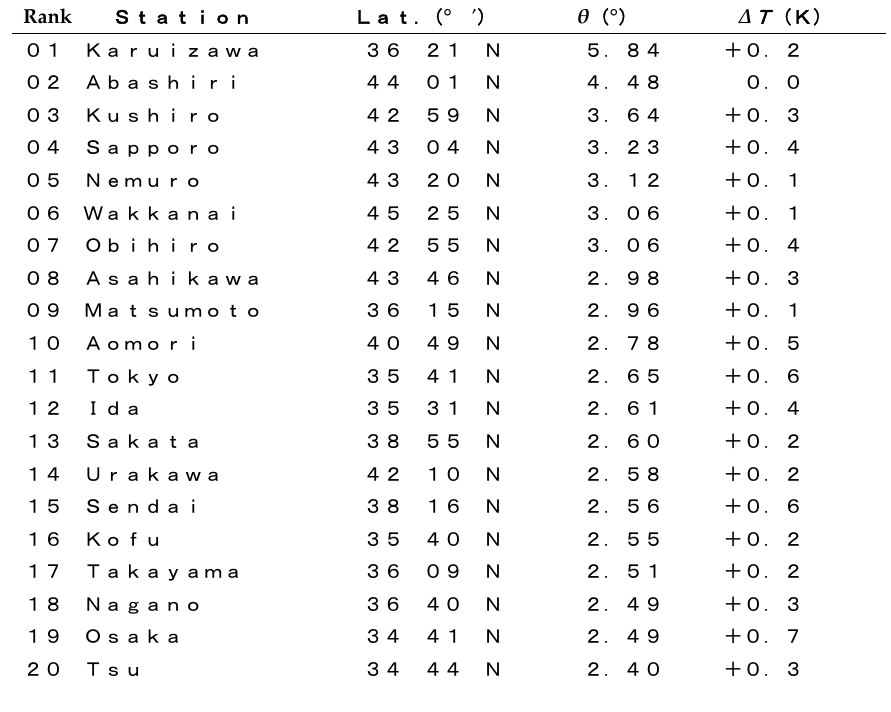
Table 5. Top-twenty Japanese stations in the rotation angle of the monthly distributions of temperatures from Period I (1931–1960) to II (1951–1980).